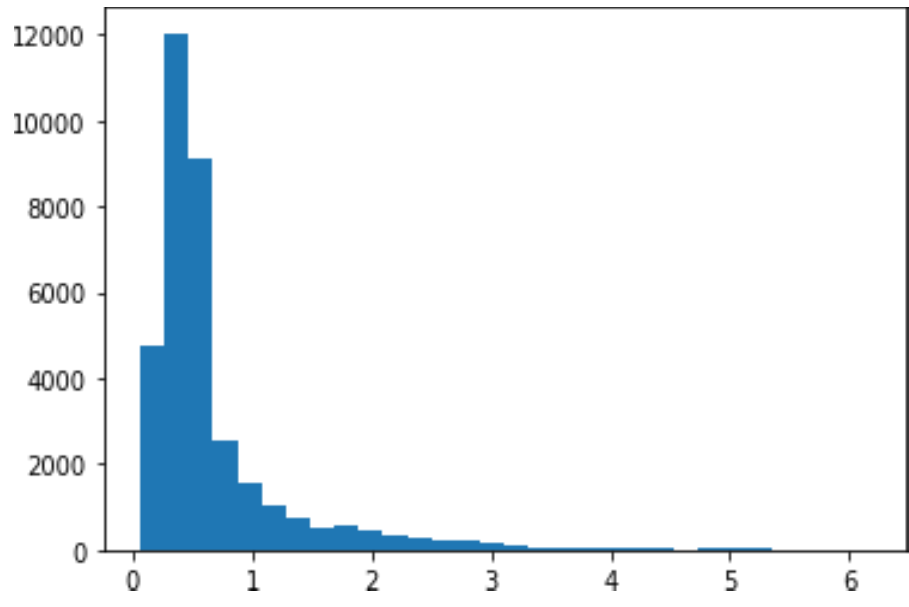
Figure 2. Train data MAE values (x-axis) vs. number of samples (y-axis).